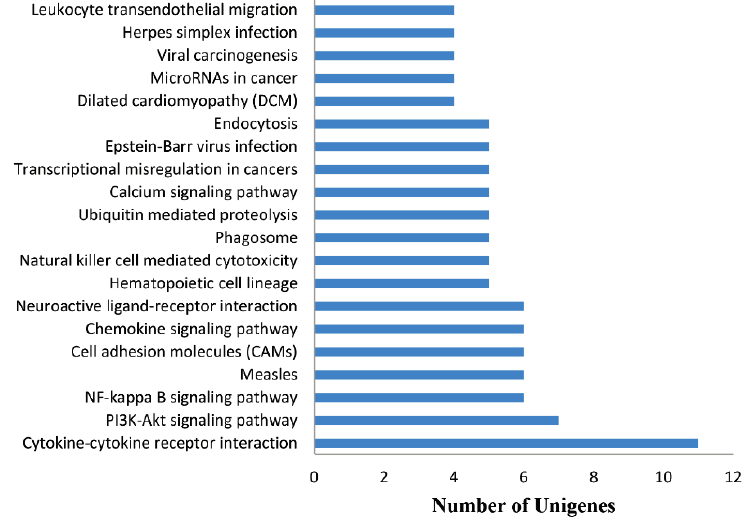
Figure 8. Top 20 KEGG pathways enriched up-regulated genes. Among the 1470 up-regulated unigenes, 11 unigenes are involved in the largest KEGG pathway “Cytokine–cytokine receptor interaction”. Five of the top 20 KEGG pathways participate directly in the immune